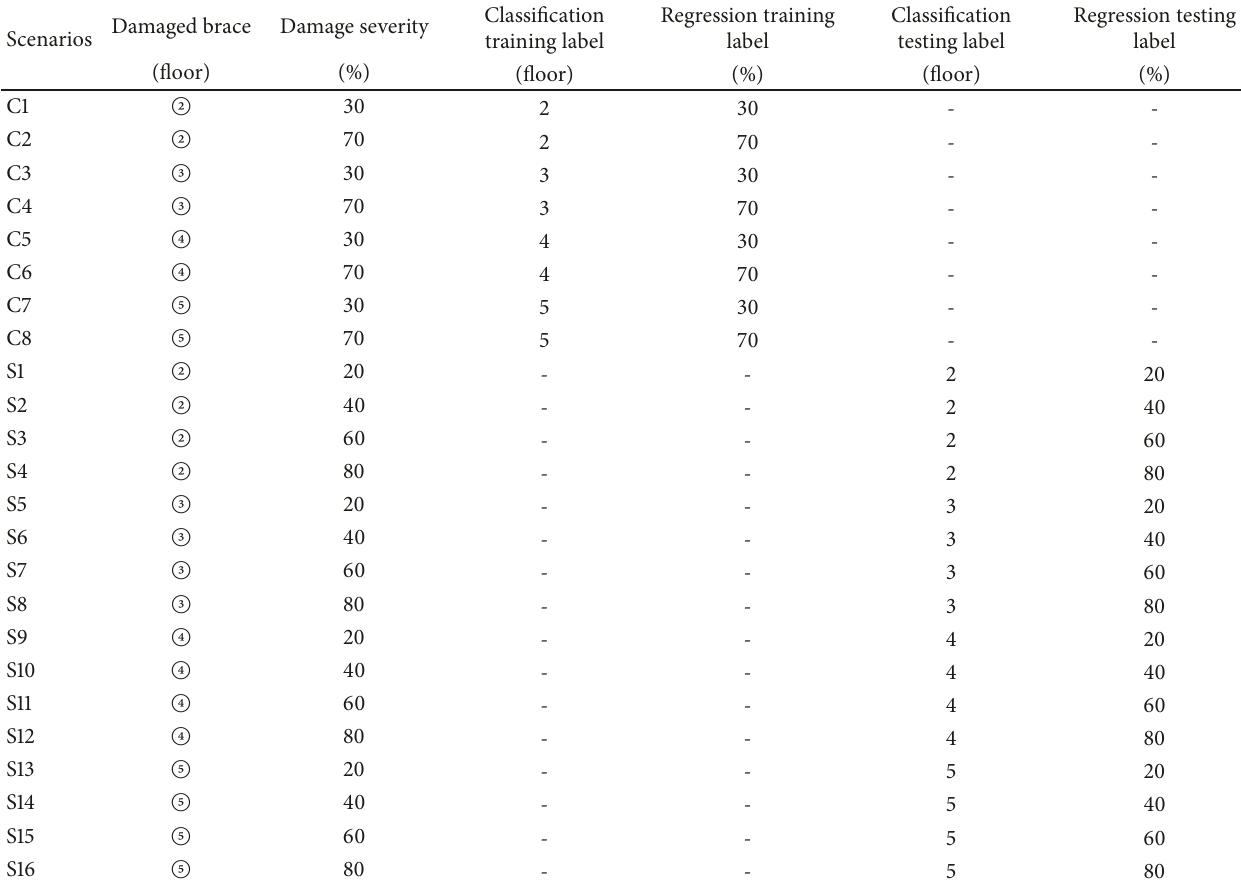
Table 1: Damage scenarios of the numerical simulation.